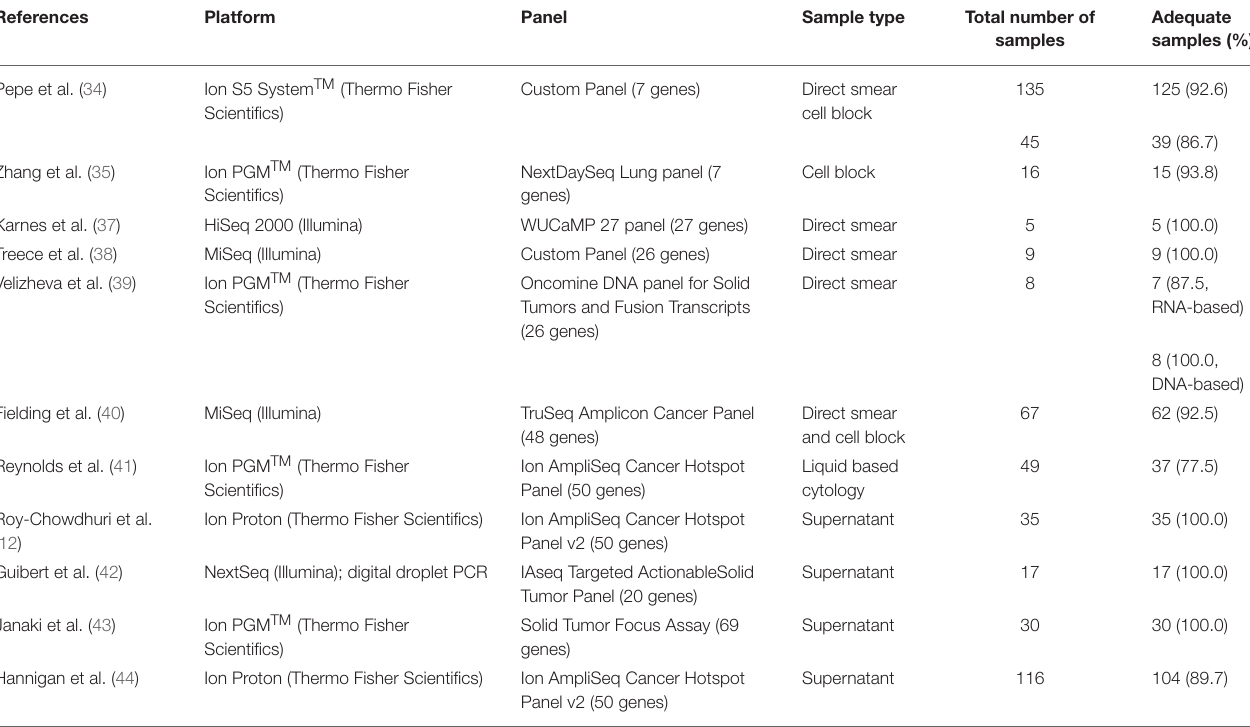
TABLE 2 | Summary of studies adopting next generation sequencing on cytological